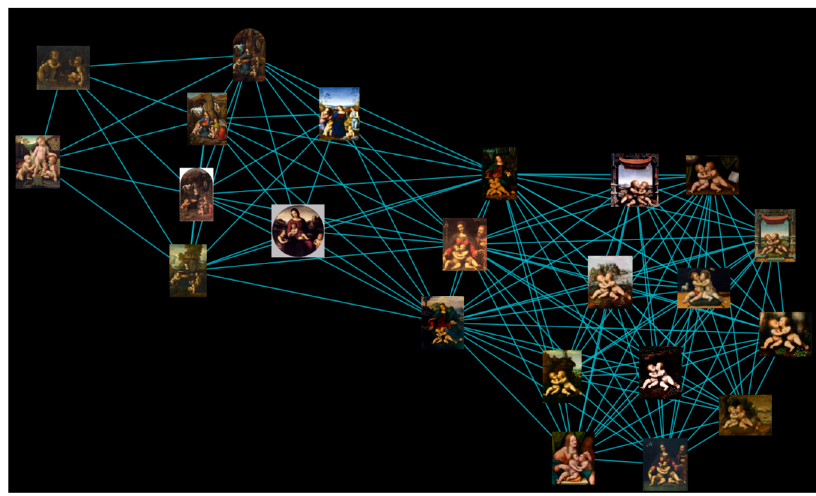
Figure 14. Visual connections of pattern propagation in the Morphograph from the Virgin of the Rocks (author : Benoit Seguin).